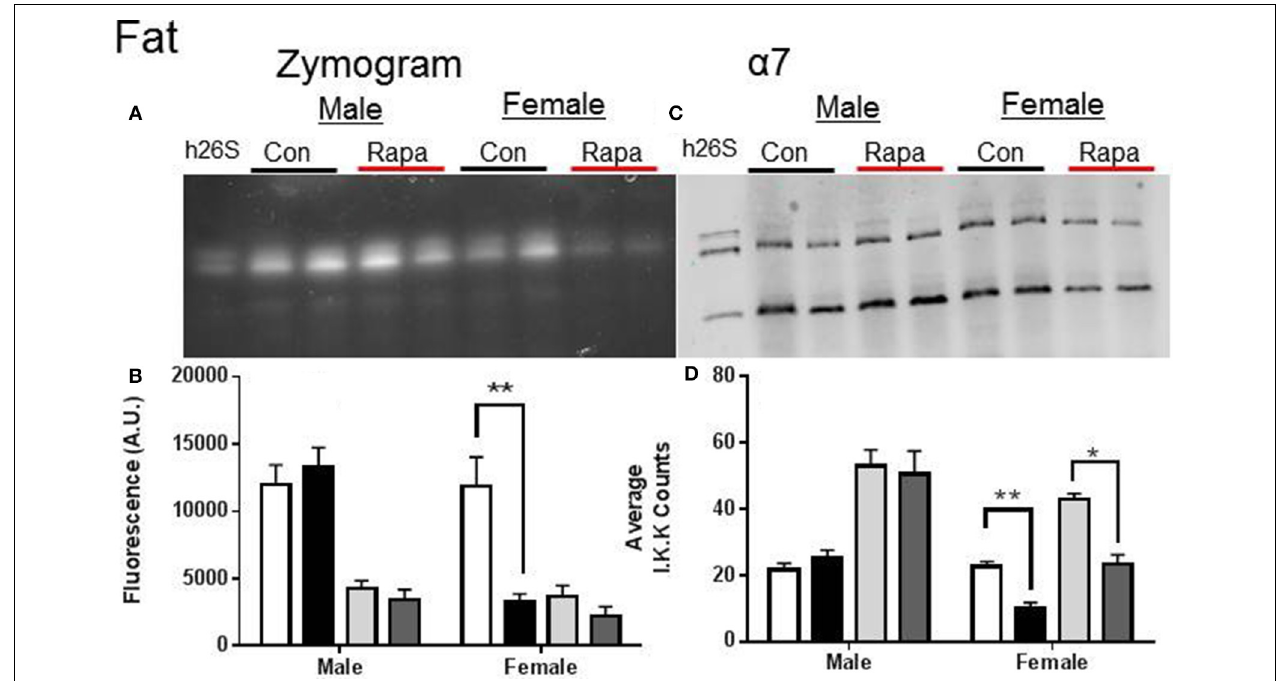
FIGURE 4 | Female Fat Lysates also showed rapamycin-influenced declines in proteasome activity. (A) Representative zymogram of Chymotrypsin-like (ChTL) proteasome activity after native gel electrophoresis of 50 μ g of visceral fat lysate from control and rapamycin-treated old male and female animals. (B) Quantitation of the zymogram revealed that there